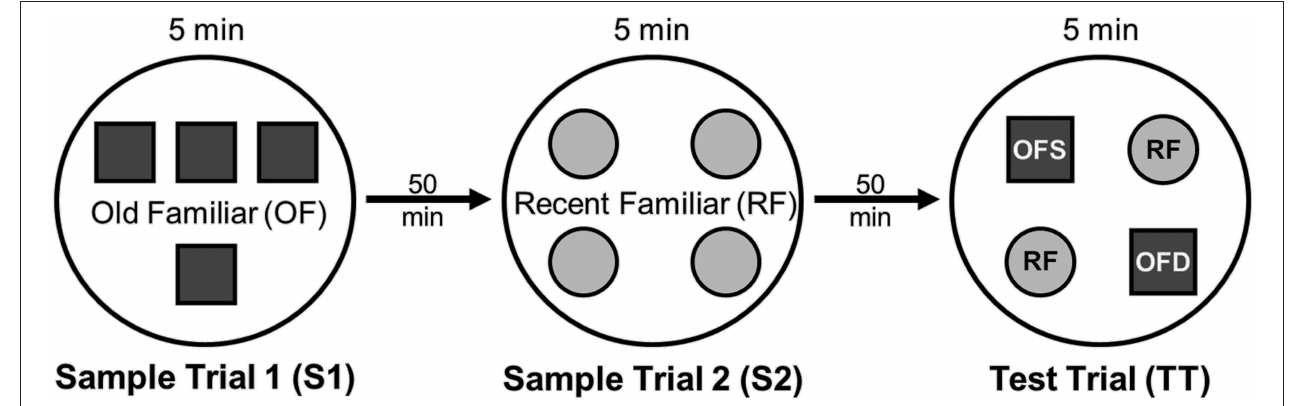
FIGURE 1 | Schematic of the experimental protocol for the What-Where-When Episodic-Like Memory Task (63). Rats explore two sets of novel quadruplicate objects during a first and second sample trial (S1 and S2, respectively). This is followed by a test trial (TT) where two Recent Familiar (RF) objects from S2 are presented in their original positions and two Old Familiar (OF) objects from S1 are present, with one placed in its original position [Old Familiar Stationary (OFS)] and one that has been displaced from its original location [Old Familiar Displaced (OFD)]. Each trial is 5min in duration and separated by an inter-trial interval of 50min.